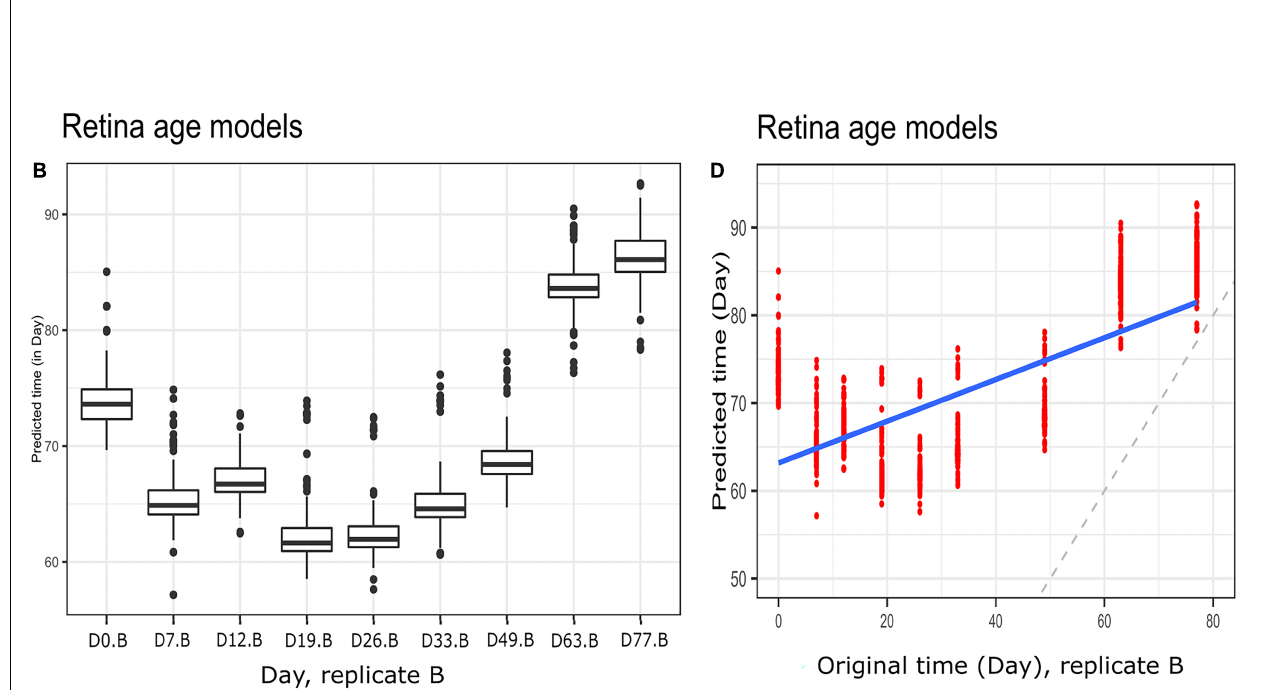
FIGURE 5 | Boxplots of predicted time (clock age in days) during neuronal differentiation. (A) Group A replicates, (B) group B replicates. Regression plots showing predicted time (age) and original differentiation time for (C) group A replicates, (D) group B replicates. Shown are data for neuronal differentiation samples and retina (AMD MGS1) age models. Note the discrepancy between actual ages (in days) and clock age estimates (in days).